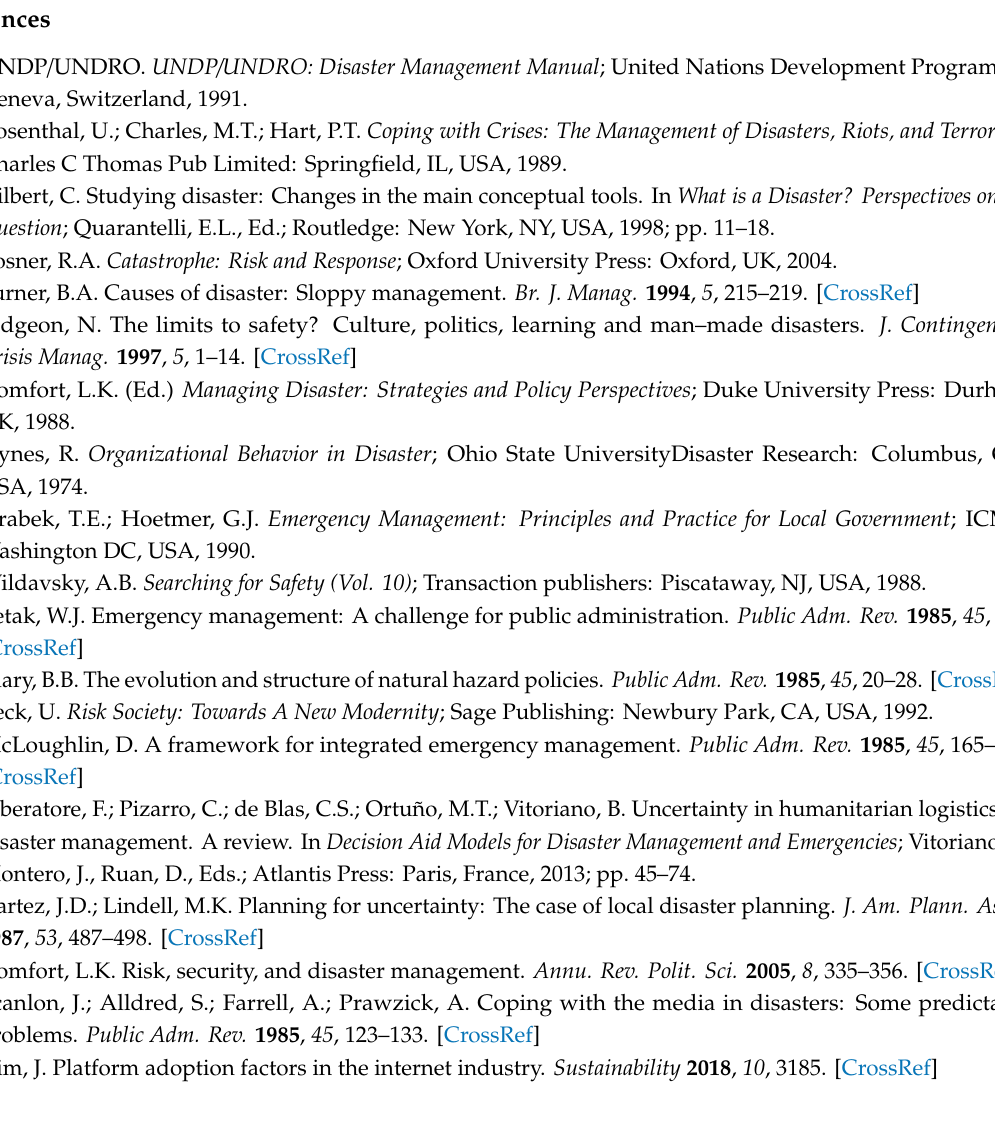
Table S1: Korea Crisis Management Timeline, Table S2: Korea Crisis Management phase